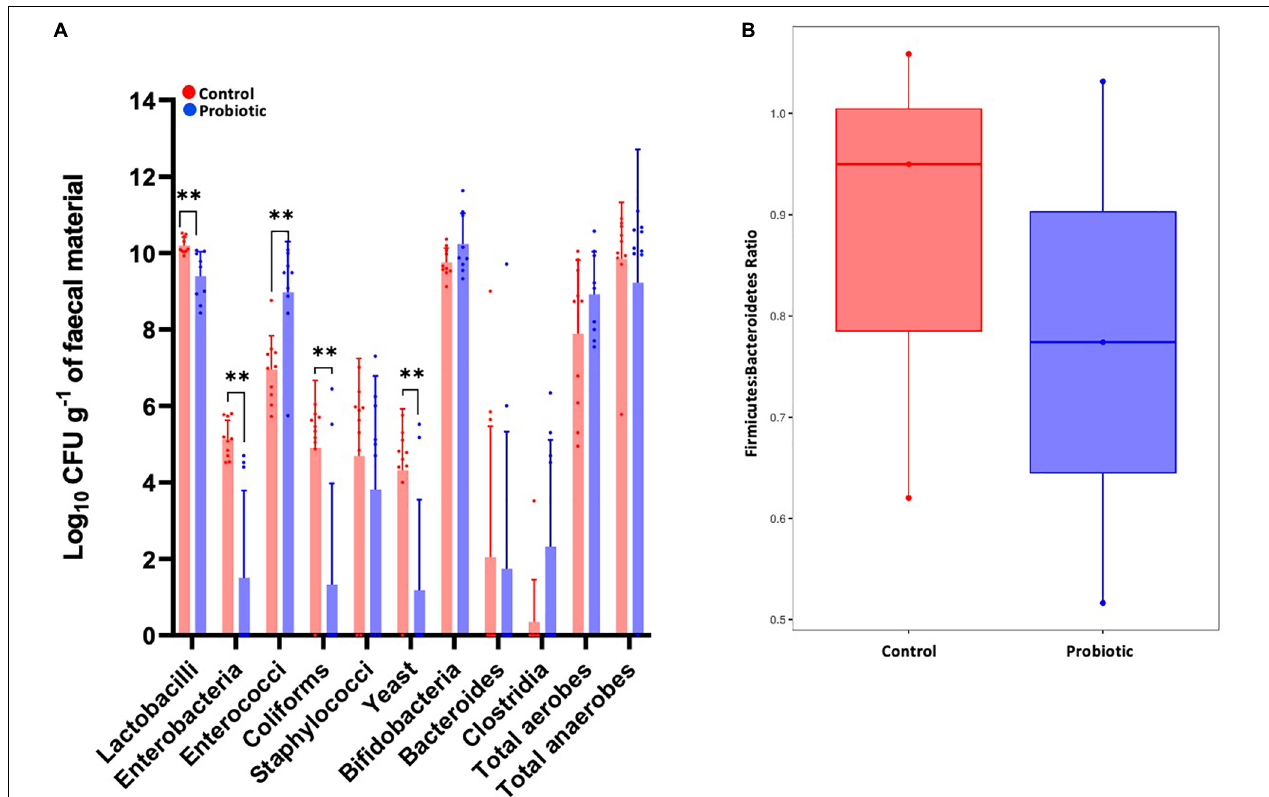
FIGURE 7 | The composition of the faecal microbiota by ex vivo culture. Viable numbers of (A) common gut bacteria or (B) the Firmicutes-to-Bacteroidetes ratio in the faeces of 3xTg-AD mice at the end of the intervention period. For (A) , values of p were determined using an unpaired t test where ** p <